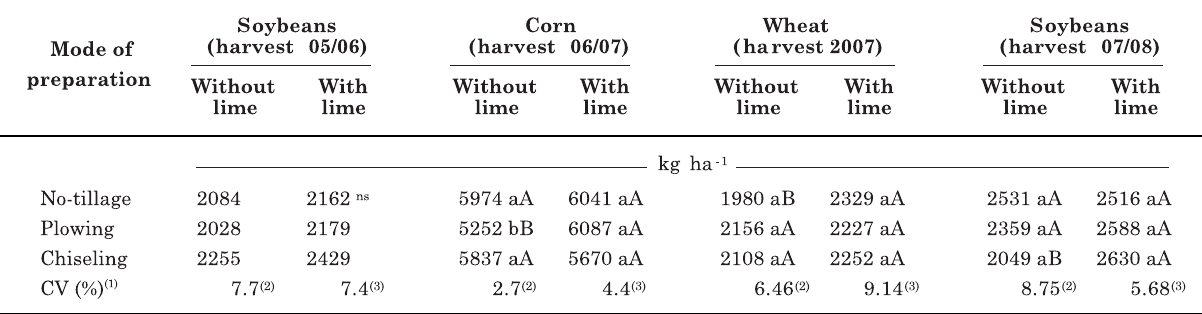
Table 2. Grain yield in the harvests of 2005/2006, 2006/2007, 2007 and 2007/2008 in an Oxisol under the no-till system, submitted to different modes of tillage and